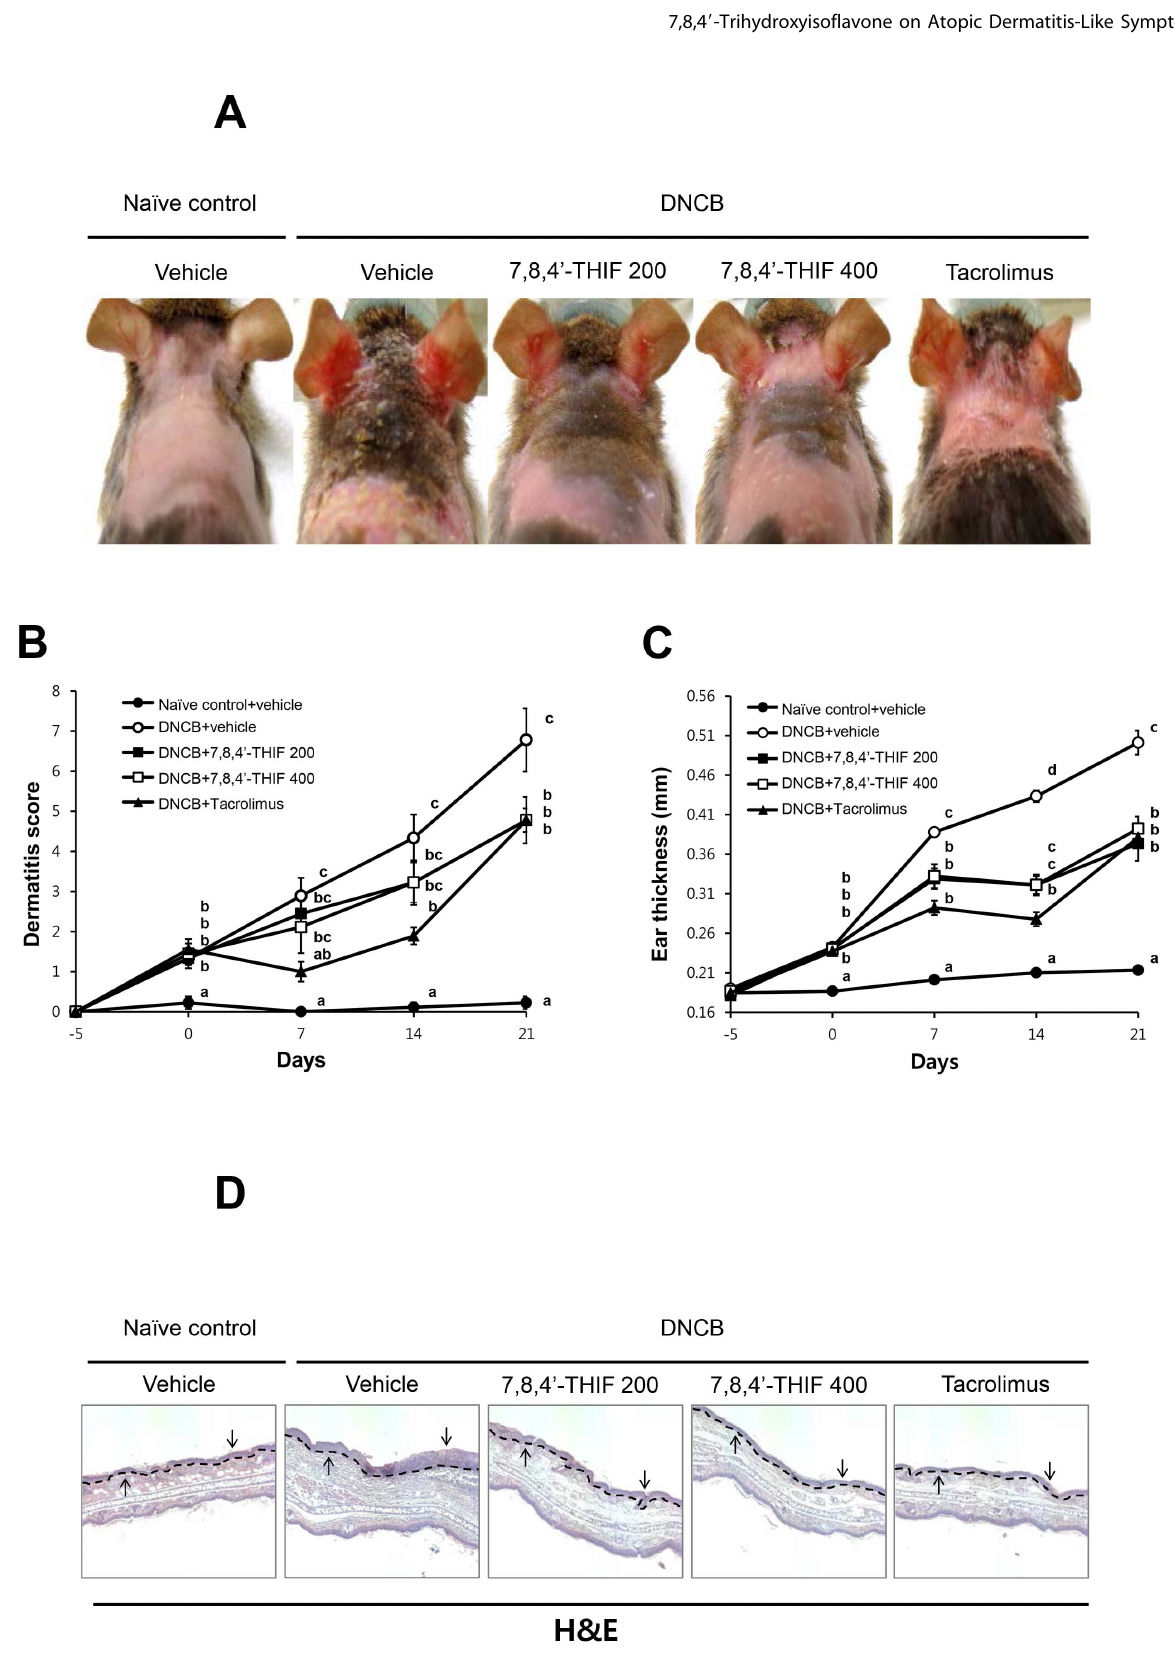
Figure 2. Effect of 7,8,4 9 -THIF on DNCB-induced AD-like symptoms in NC/Nga mice. (A) Images of skin lesions from the groups of mice were taken on the last day of the experiment (day 21). (B) Dermatitis scores were evaluated weekly from day 2 5 to 21. (C) Ear thickness was measured from day 2 5 to 21. (D) H&E-stained ear skin on day 21 (100 6 ). Arrows indicate epidermal hypertrophy. Data represent the mean 6 SEM (n=9). Means with letters (a–d) within a graph are significantly different from each other at p , 0.05. doi:10.1371/journal.pone.0104938.g002 PLOS ONE |